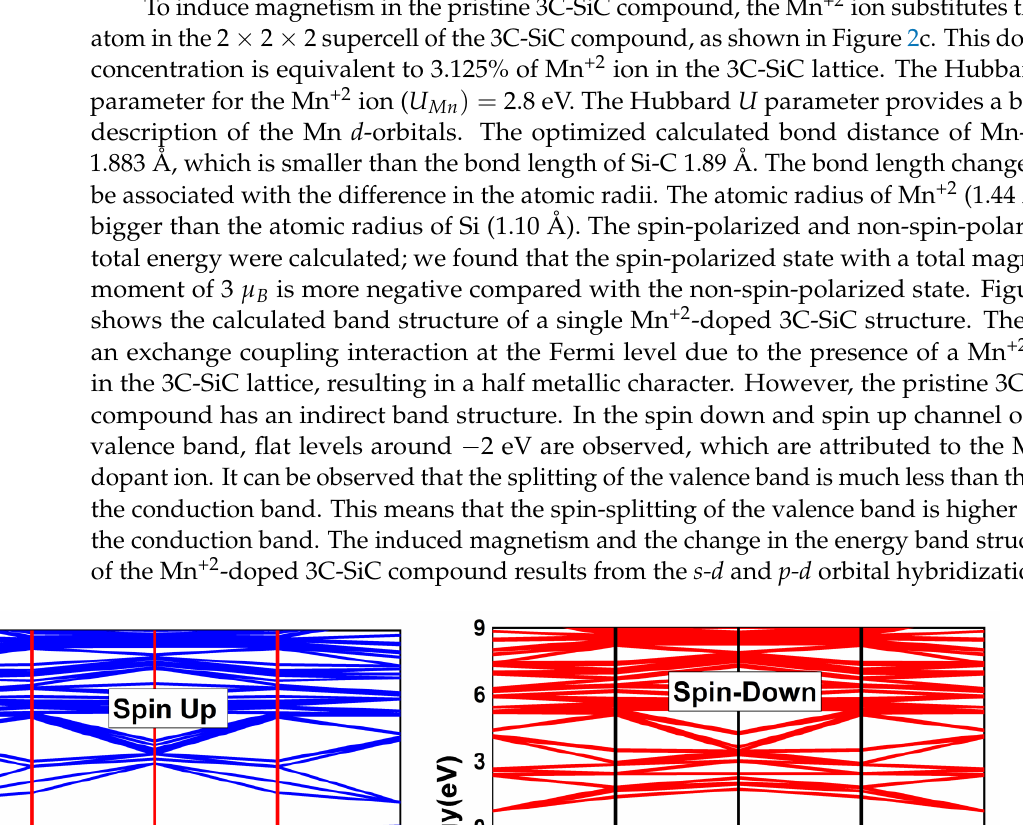
Figure 5. Spin polarized ( a ) total density of state (TDOS) and ( b ) partial DOS of ( Mn +2 )-doped 3CSiC. Fermi level denoted by a red dash line. The orbital of (Mn +2 )- 3d splits into three-fold degenerate state antibonding 𝑡 2𝑔 ( 𝑑 (𝑥𝑦) , 𝑑 (𝑦𝑧) , 𝑑 (𝑥𝑧) ) and two-fold degenerate state nonbonding 𝑒 𝑔 ( 𝑑 𝑥 2 −𝑦 2 , 𝑑 𝑧 2 ) , according